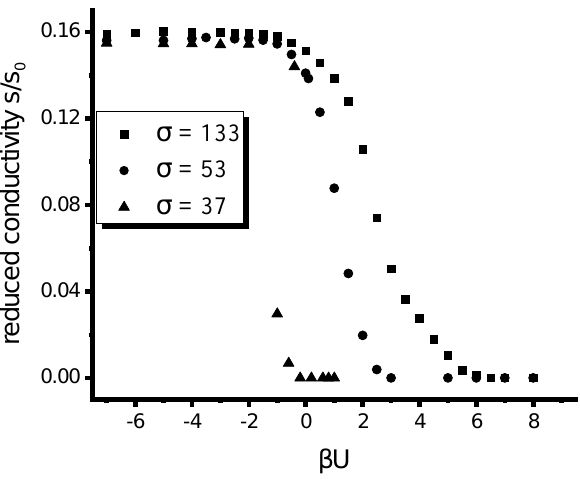
Figure 5. Effect of the interaction between fillers on the conductivity of the filled microphase-separated DBC system for several selected values of the affinity contrast σ ∼ ∆ γ . The volume fraction of particles φ is set equal to